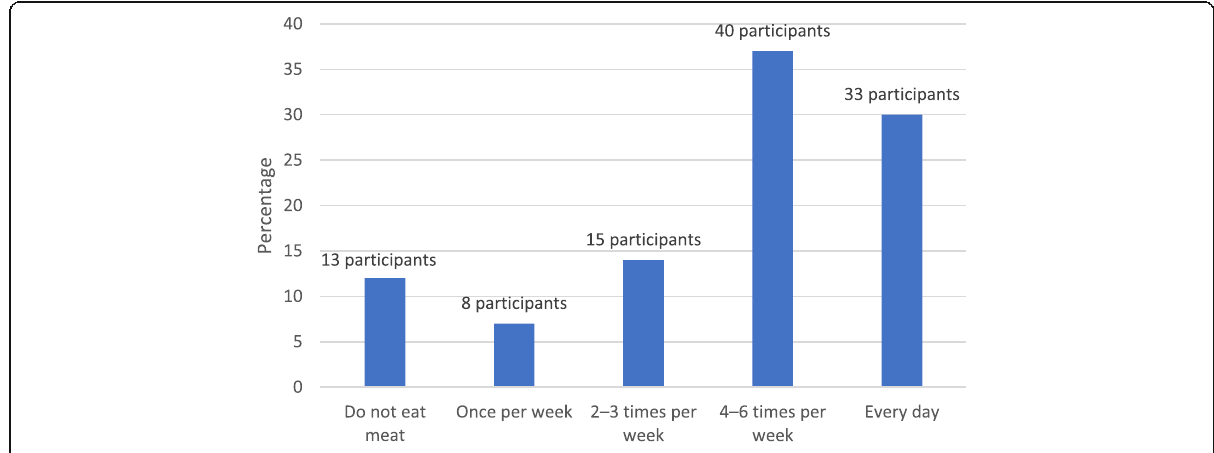
Fig. 2 Meat consumption of people who are aware of its negative impact on planetary health: 2018 Sydney responses